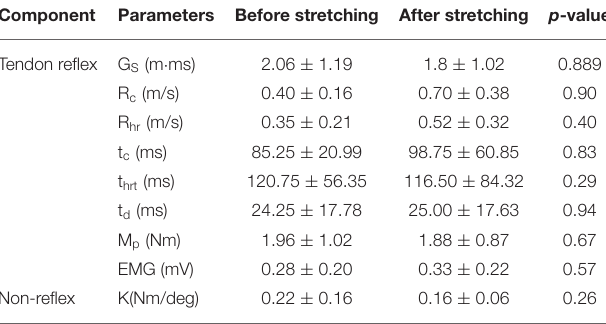
TABLE 2 | Results from the tendon reflex and passive stiffness analyses. Component Parameters Before stretching After stretching p -value Tendon reflex G S (m ·